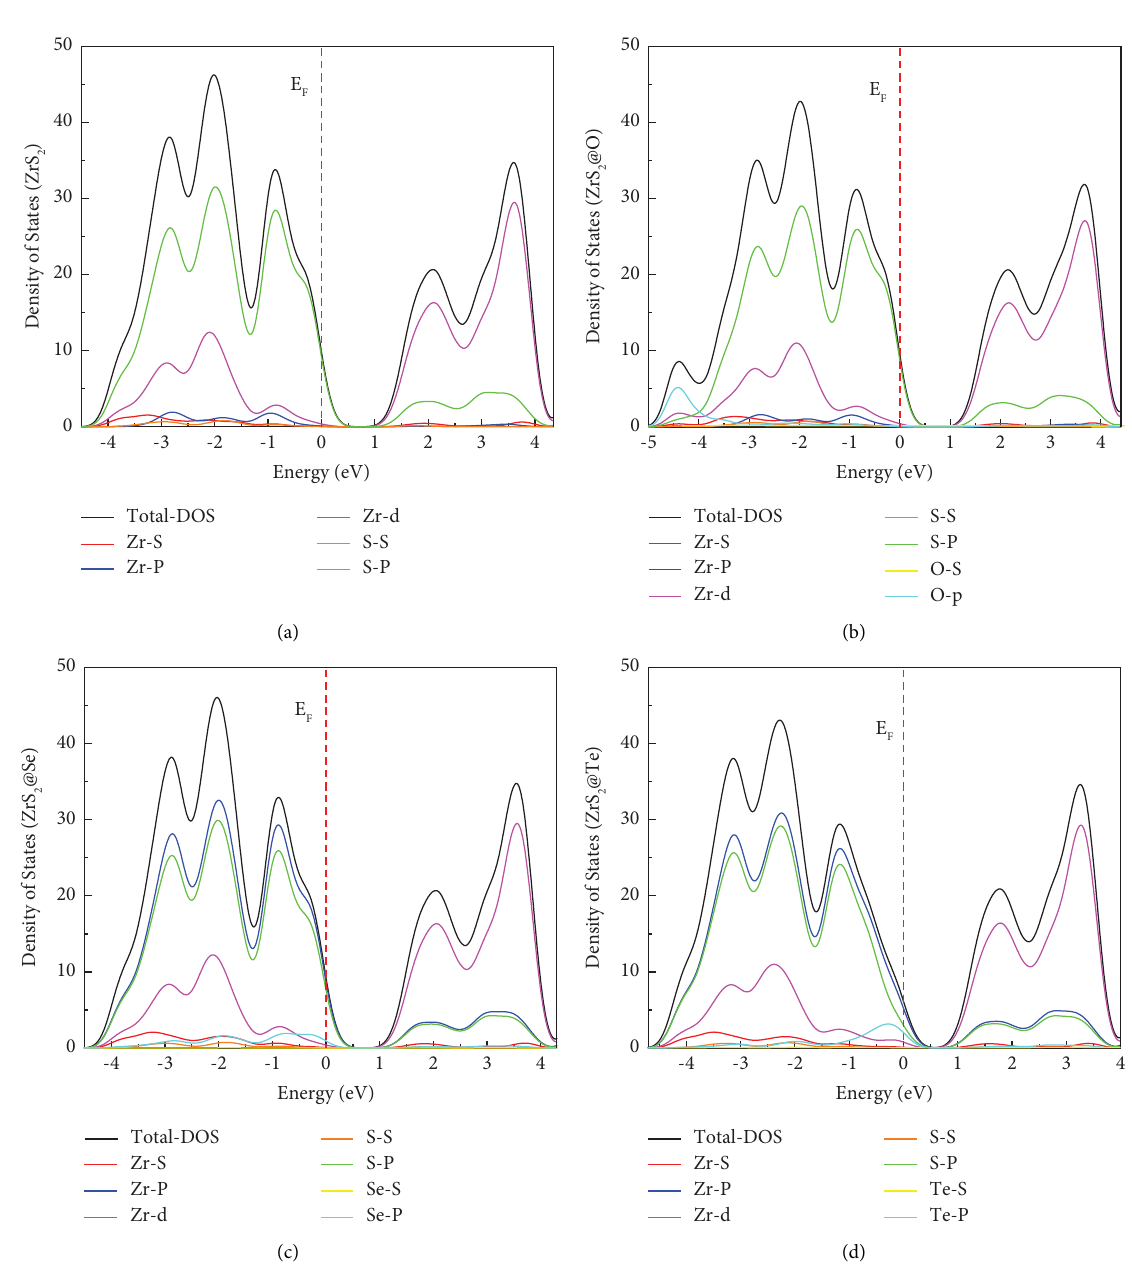
2 monolayers. (a) Pristine ZrS 2 . (b) O-doped ZrS 2 . (c) Se-doped ZrS 2 . (d)